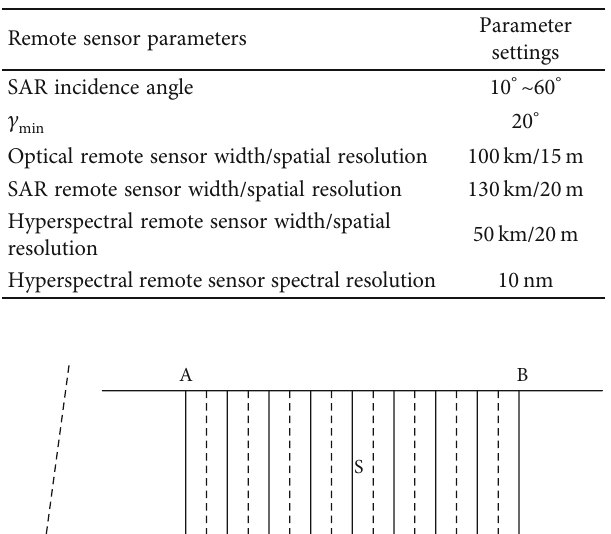
Table 3: Remote sensor simulation parameters.